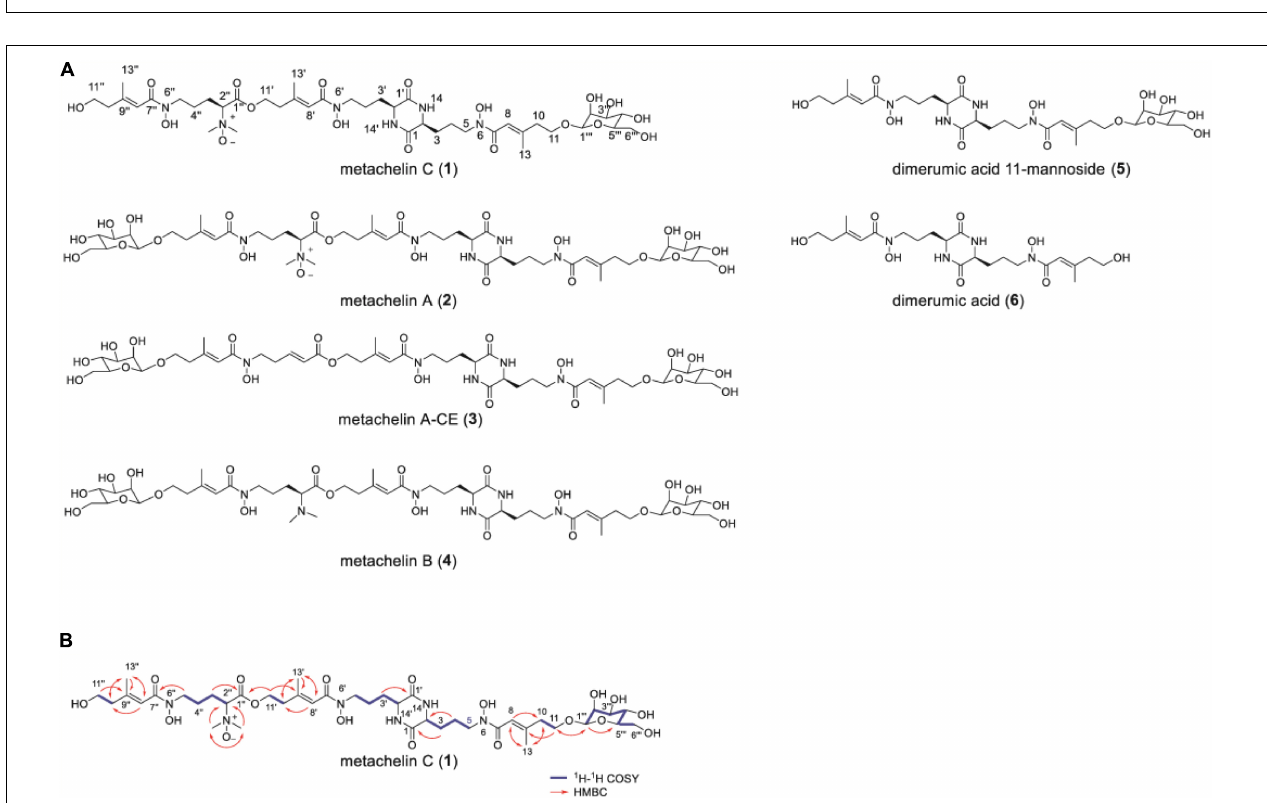
FIGURE 2 | Mannosylated coprogens and dimerumic acids isolated from M. robertsii . (A) Structures of metachelin C ( 1 ) and compounds 2 – 6 ; (B) selected key 1 H- 1 H COSY, and HMBC correlations of metachelin C ( 1 ).